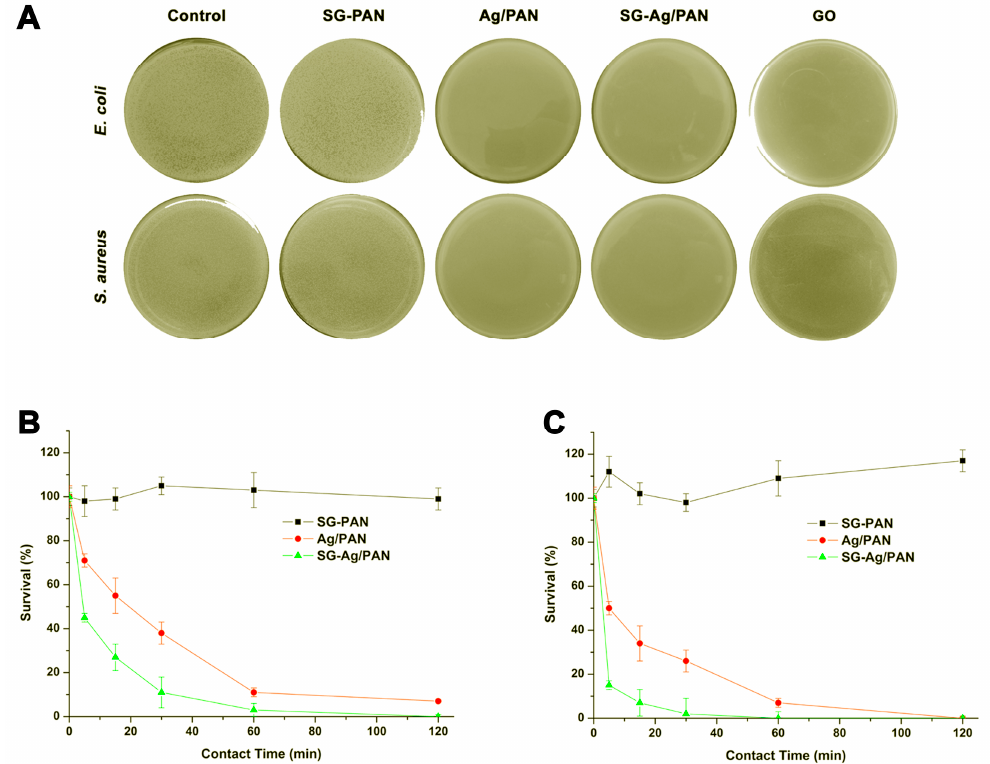
Figure 8. ( A ) Photographs of the bacterial culture plates of E. coli and S. aureus after 120 min of exposure to nothing (the control) or to SG-PAN, Ag/PAN, or SG-Ag/PAN electrospun fibers, or to graphene oxide (GO). Antibacterial kinetic tests for SG-PAN, Ag/PAN, and SG-Ag/PAN electrospun fibers against ( B ) E. coli and ( C ) S. aureus